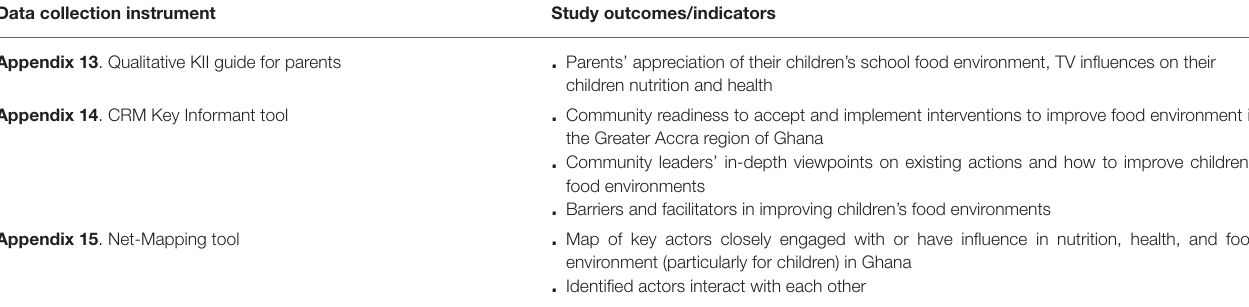
Data collection instrument Study